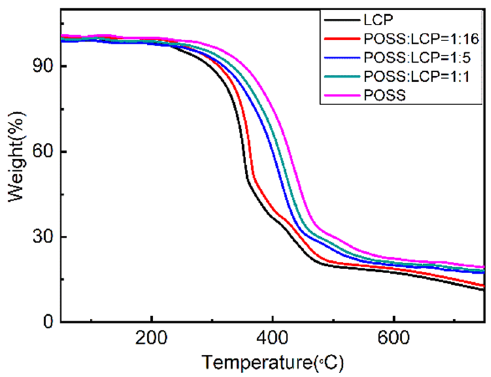
Figure 4: TG heating curves of LCP and LCP -